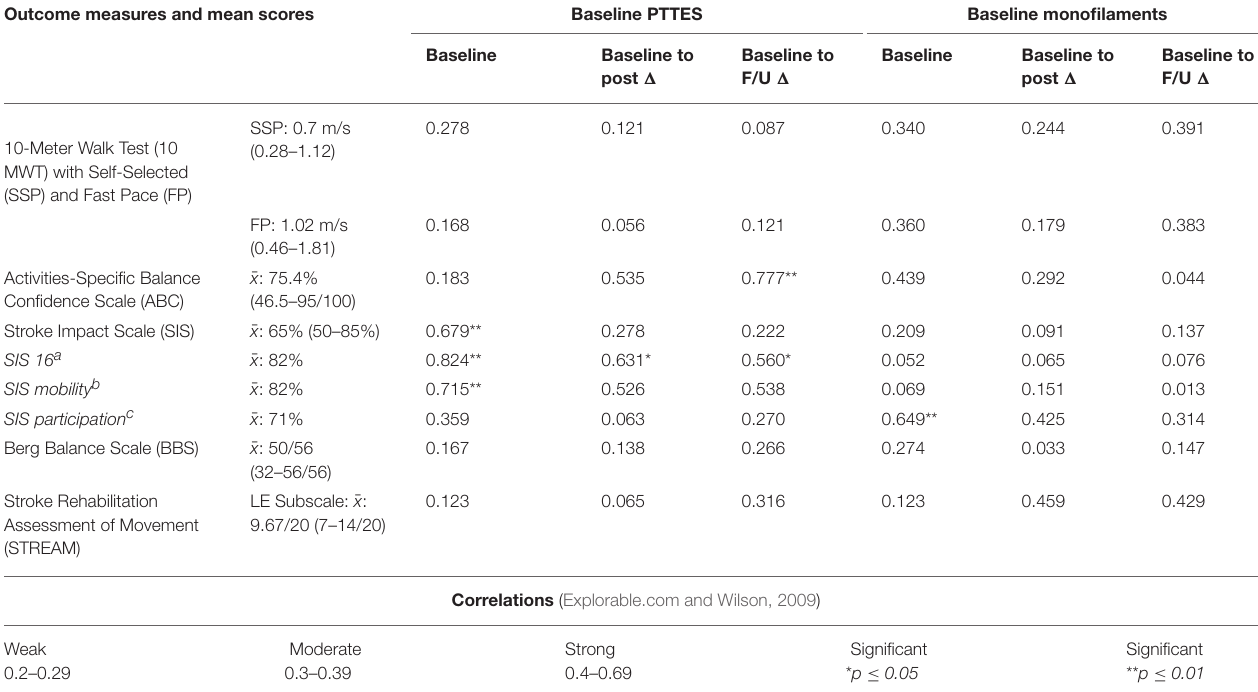
TABLE 4 | Correlations between outcome measures and sensory data. Outcome measures and mean